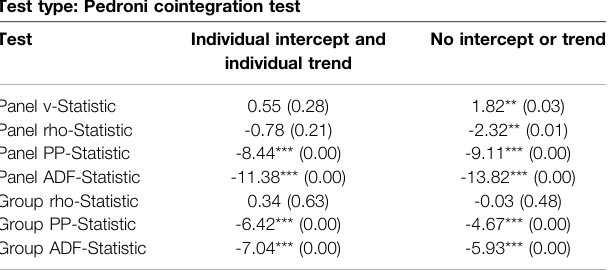
TABLE 4 | Results of pedroni cointegration tests.